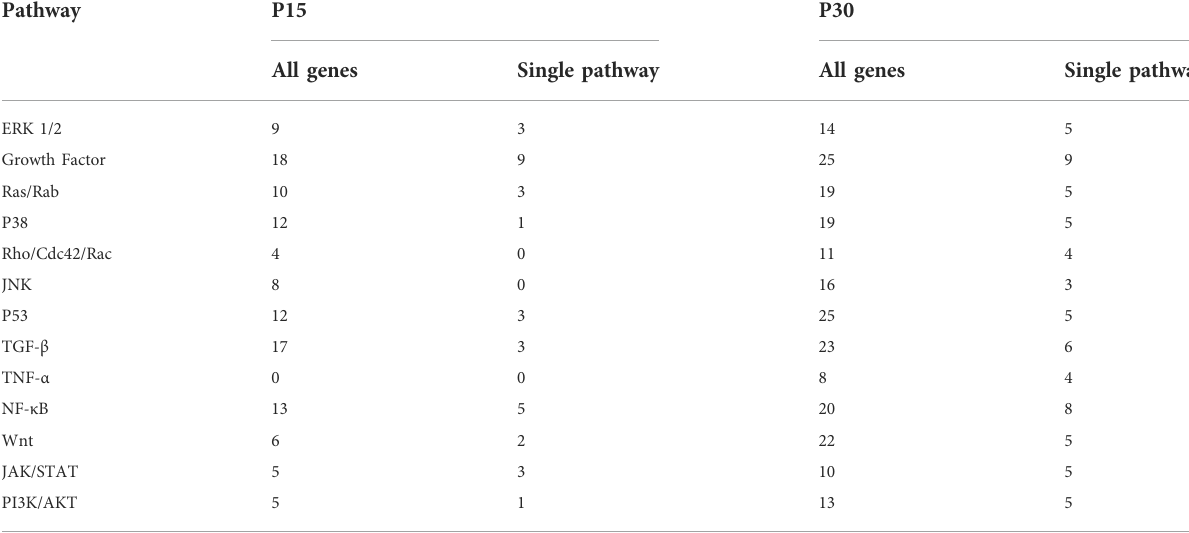
Figure 6 plots the single-pathway annotated gene expression pro fi les of P15 (left column) and P30 (right column) by Classical, SAPK, and Other family groupings. To discriminate between 1 and 6 h, time is presented in log scale. Genes differentially expressed in both age groups are traced in gray, while genes solely in P15 are traced in blue and in P30 traced in red. More genes were differentially expressed at more time points with higher